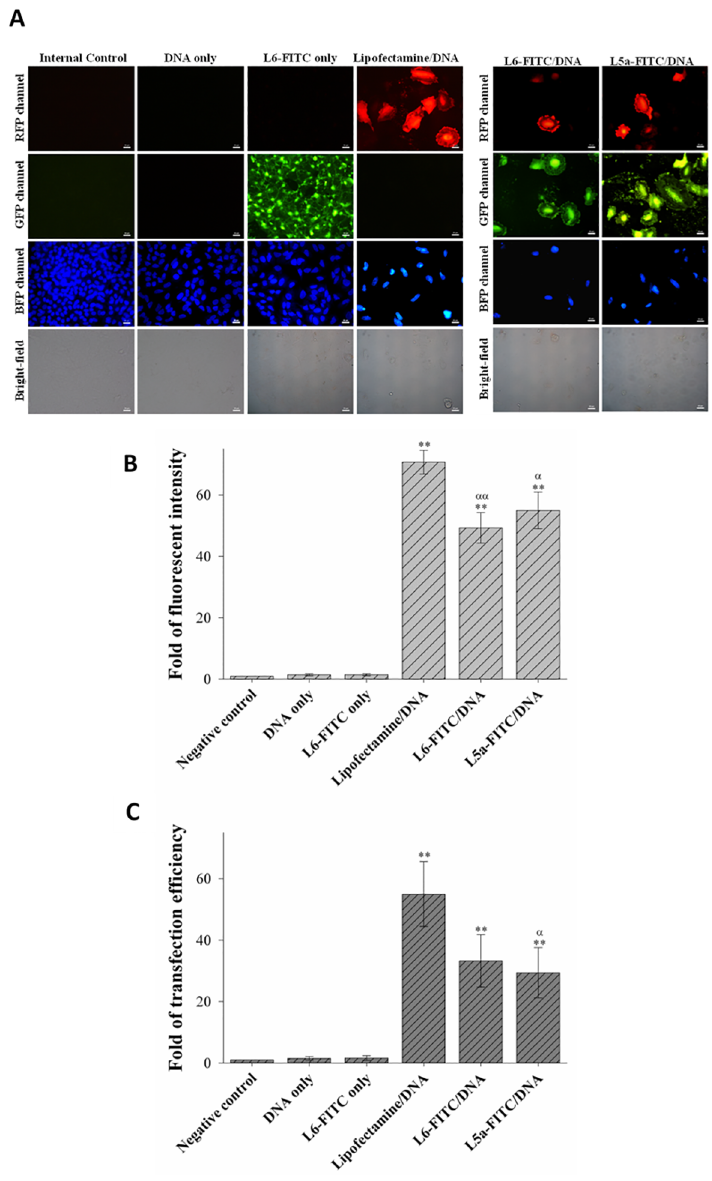
Fig 5. Functional assay of cellular delivery of reporter gene plasmid mediated by L6 and L5a. (A) Images of the FITC-labeled CPP-mediated delivery of the pCAGGS-tdTomato plasmid DNA into cells. L6-FITC or L5a-FITC was premixed with the pCAGGS-tdTomato plasmid at an N/P ratio of 12. These CPP/ DNA complexes, DNA alone and CPP alone were incubated with A549 cells for 1 h. Untreated cells and cells treated with Lipofectamine 2000/DNA complexes served as negative and positive controls, respectively. Following the 1 h incubation, cells were washed with PBS and incubated at 37°C for an additional 48 h. BFP, GFP, and RFP channels displayed the distribution of nuclei stained by Hoechst33342, CPP-FITC, and tdTomato, respectively. Cell morphologies were observed in bright-field images. All images are obtained using a Nikon Eclipse 80i fluorescent microscope at a magnification of 1,000×. (B) Expression of reporter gene delivered by CPPs. Fluorescent intensity recorded in panel A was quantified using UN-SCAN-IT software, and analyzed by ANOVA. Data are presented as mean ± SD from three independent experiments in each treatment group. Experimental groups were compared with the negative control. Significant differences from the negative control at P < 0.05 ( α ) and P < 0.01 ( ** , αα ) are indicated. (C) Transfection efficiency of CPP-mediated delivery of gene expression. Fold increases of transfection efficiency recorded in panel A were quantified using UN-SCAN-IT software. Statistical comparisons were performed by ANOVA. Data are presented as mean ± SD from three independent experiments in each treatment group. Significant differences from the negative control at P < 0.05 ( α ) and P < 0.01 ( ** ) are